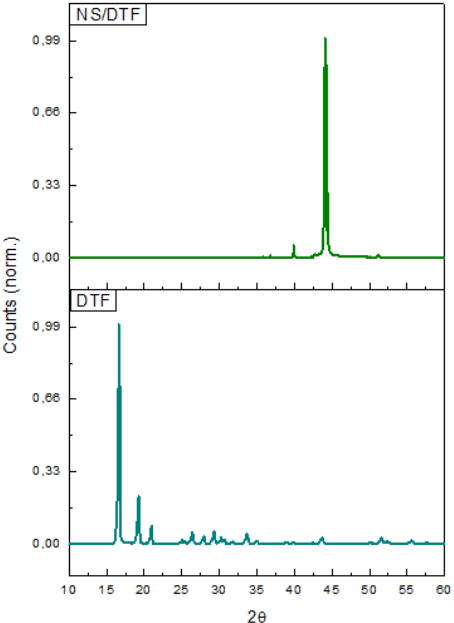
Figure 4. XRPD analysis of DTF and the NS–DTF inclusion complex.